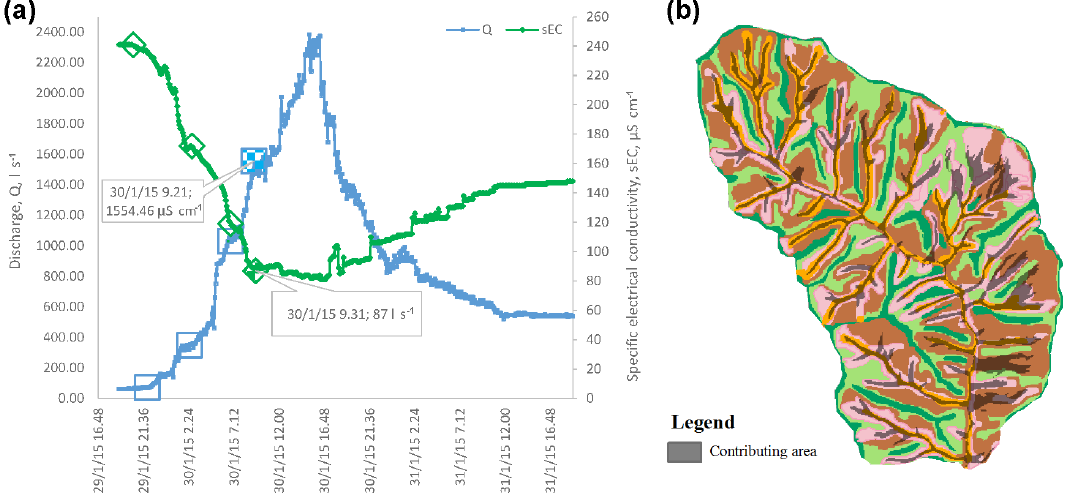
Figure 12. Advanced hydro-chemograph conditions, after approximately 80mm of rainfall, with approximately Q = 1550Ls − 1 , filled blue square and approximately EC = 90µS − 1 , filled green diamond, (b) scenarios corresponding to a full saturation excess contribution to streamflow along the riparian corridor and the whole colluvial hollows, respectively.